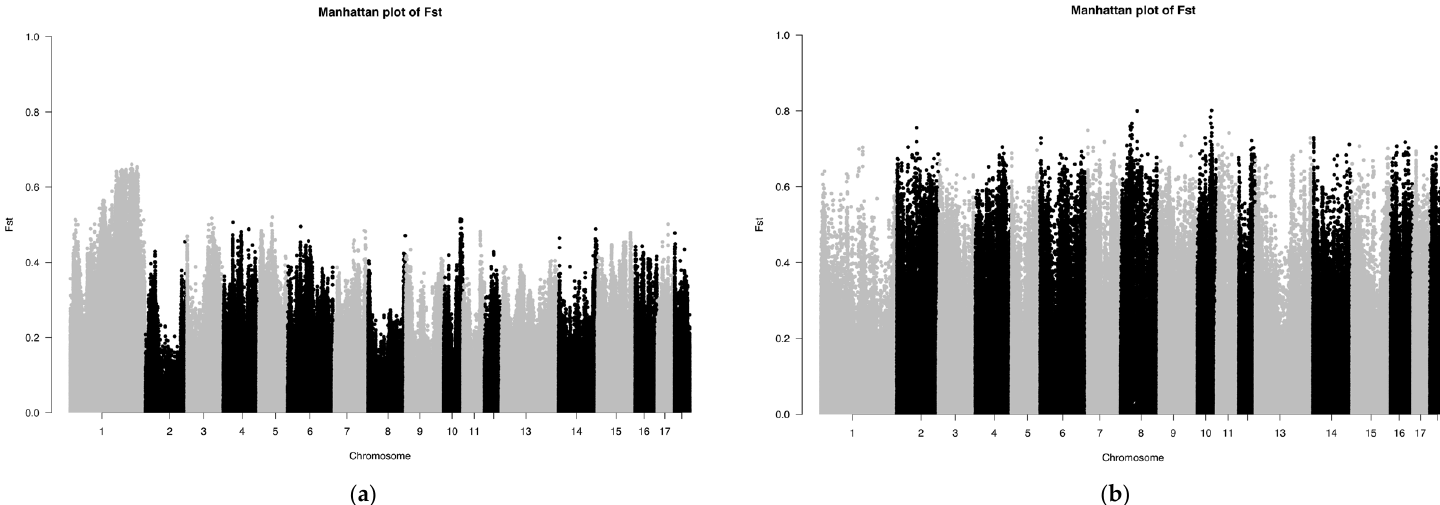
st of LU–LW and LU–YY pigs by SNP